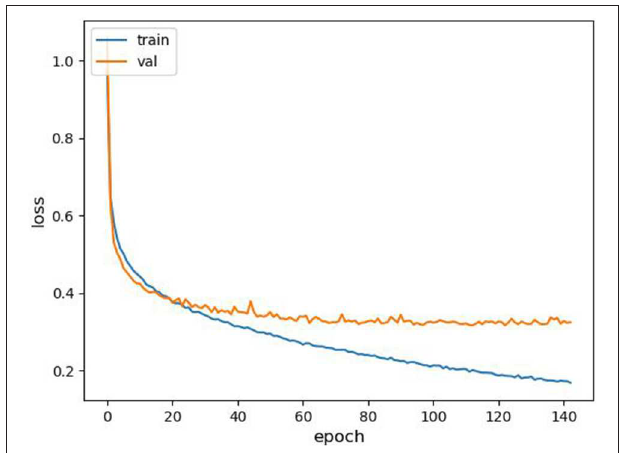
FIGURE 1 | Learning curve history comparing training and validation